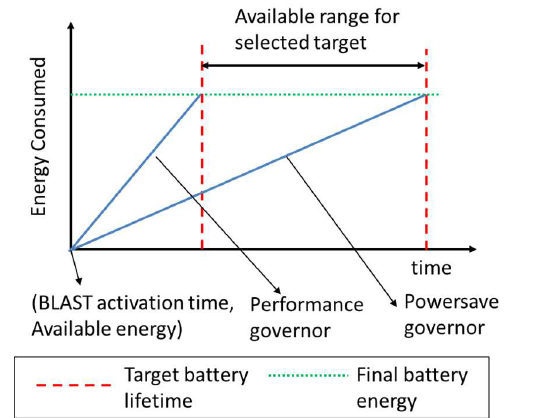
Figure 2. Range for selected